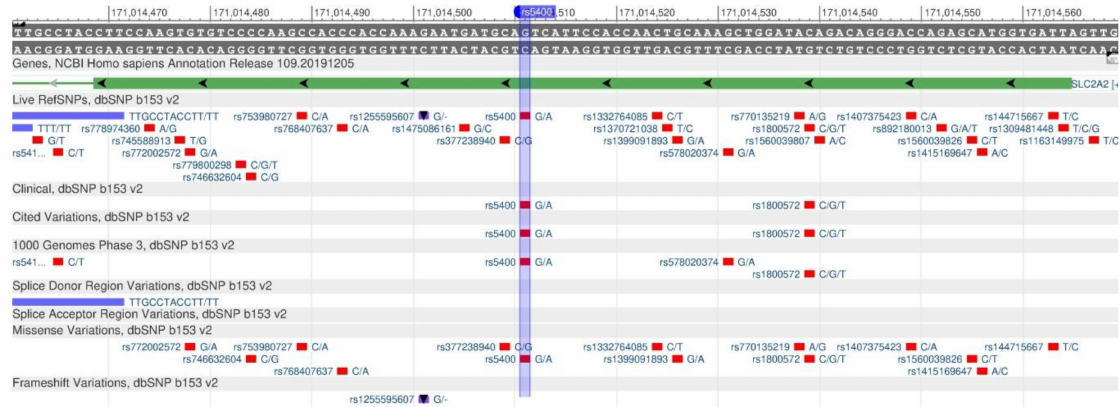
Figure 25. The GLUT2 gene region (located on the long (q) arm of chromosome 3) containing the rs5400 oligonucleotide polymorphism.